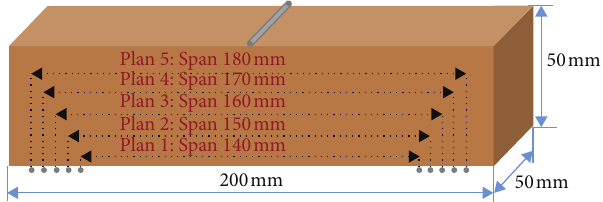
Figure 2: Fulcrum span